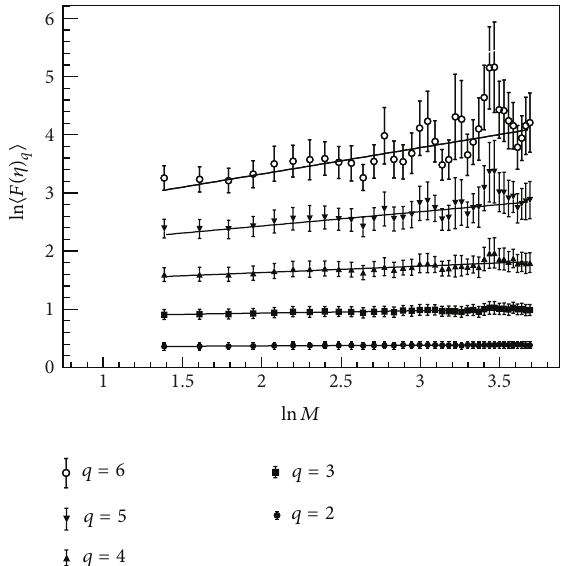
Figure 15: Intermittent behaviour of charged hadrons produced in 𝜂 -space in 28 Si-Ag/Br interactions at 14.6AGeV. The figure is taken from [153].